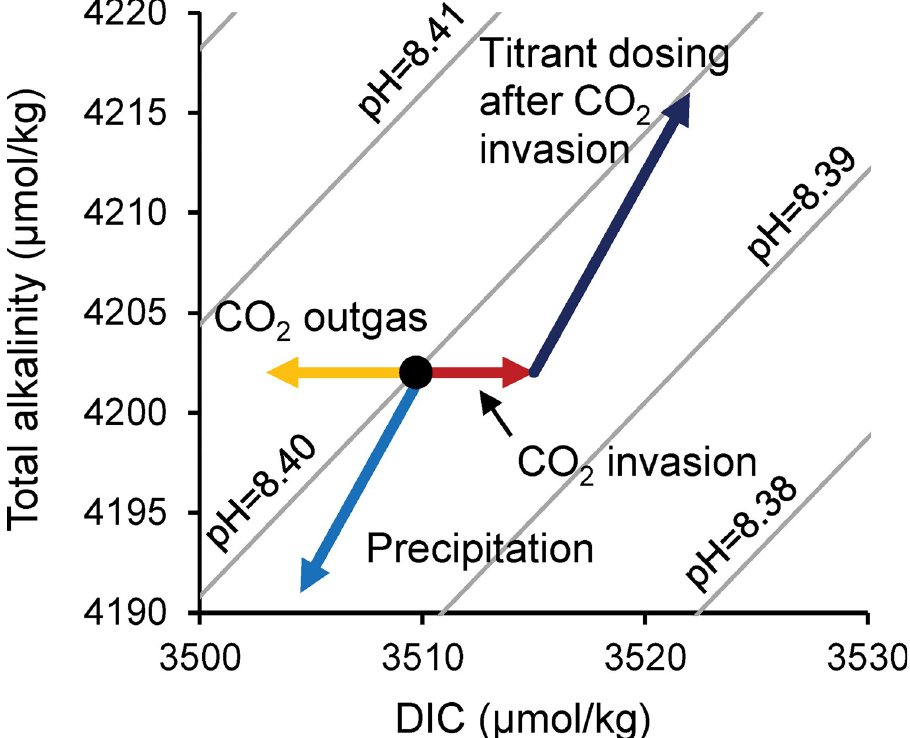
Fig 1. Effect of processes on the DIC chemistry of seawater. Precipitation reduces DIC, alkalinity and hence pH. Titrant dosing after precipitation returns the DIC to the starting composition (black dot). CO 2 invasion and outgas modify the DIC but not the alkalinity of the seawater. CO 2 invasion reduces pH and triggers the dosing of titrants which return the seawater to the starting pH but at a different DIC and alkalinity composition. Contours join points of equal pH (NBS